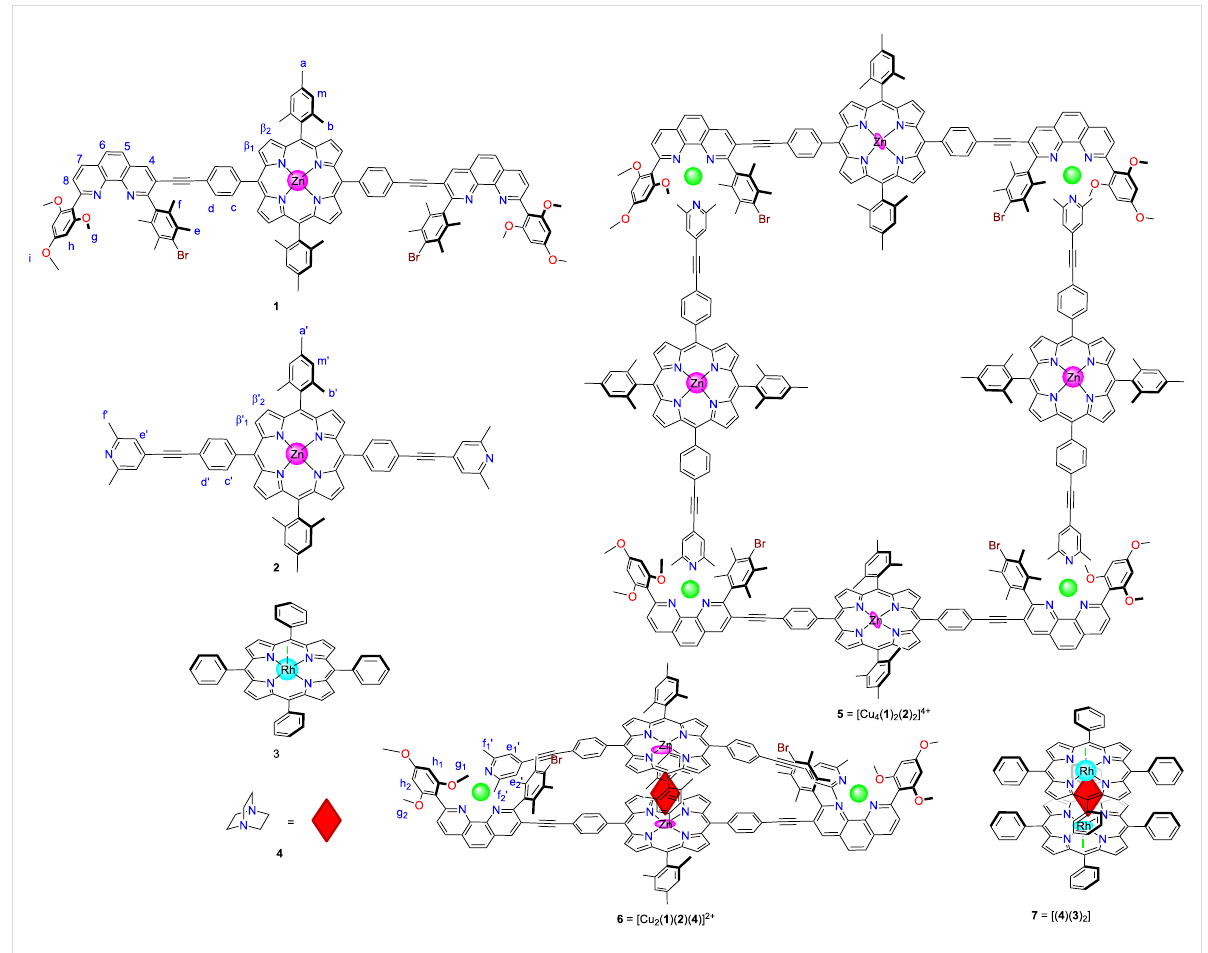
Figure 1: Molecular structures of ligands 1 , 2 , 3 , and 4 and of the resulting products, i.e., rectangle 5 , sandwich 6 and rhodium porphyrin dimer 7